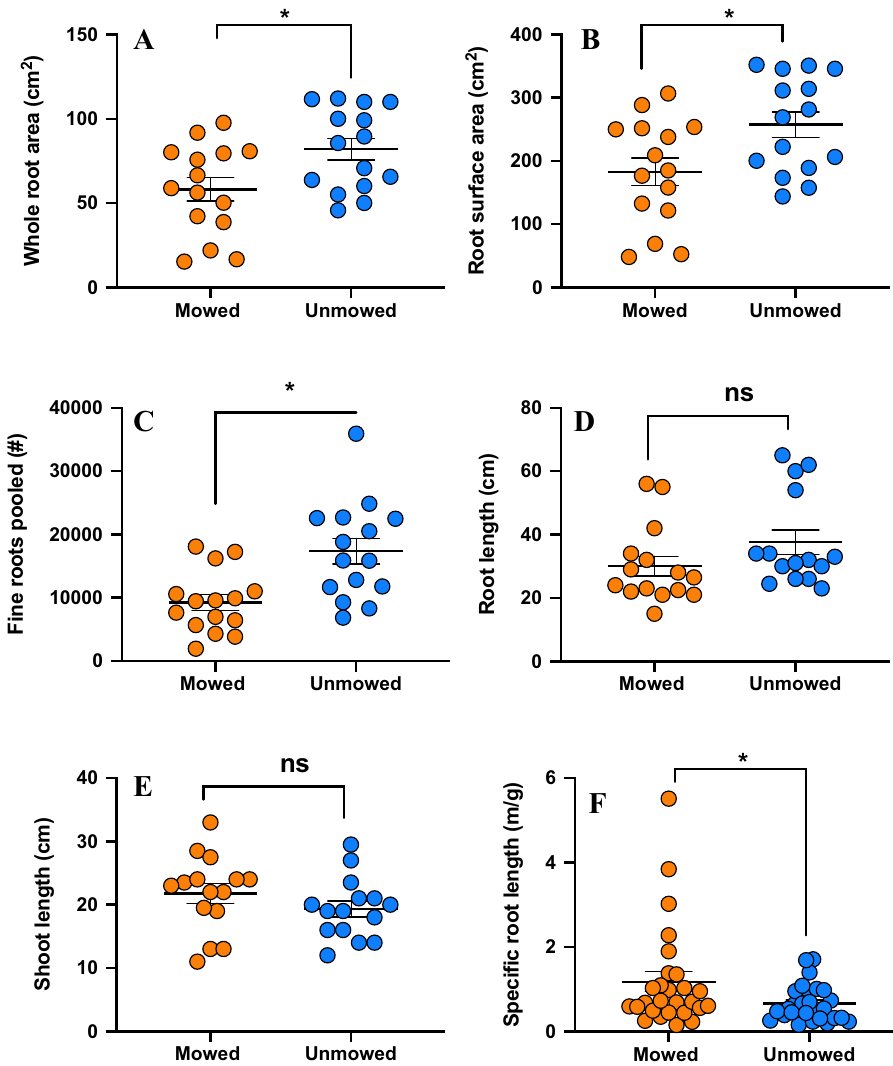
Figure 7. Results of six major root traits show: ( A ) Whole root area (P < 0.108; Kruskal–Wallis tests), ( B ) Root surface area (P = 0.017; Kruskal–Wallis test), ( C ) Fine roots pooled (P < 0.0002; Kruskal–Wallis tests), ( D ) Root length (P = 0.004; Kruskal–Wallis tests), (7E) Shoot length (P = 0.225; Kruskal–Wallis tests), (7F) Specific root length (P < 0.049; two tailed T test) on mowed (orange bar) and unmowed (blue bar) plants. Means are shown by scale bars and asterisk denotes significantly different results at p < 0.0, while ns denotes non-significant results